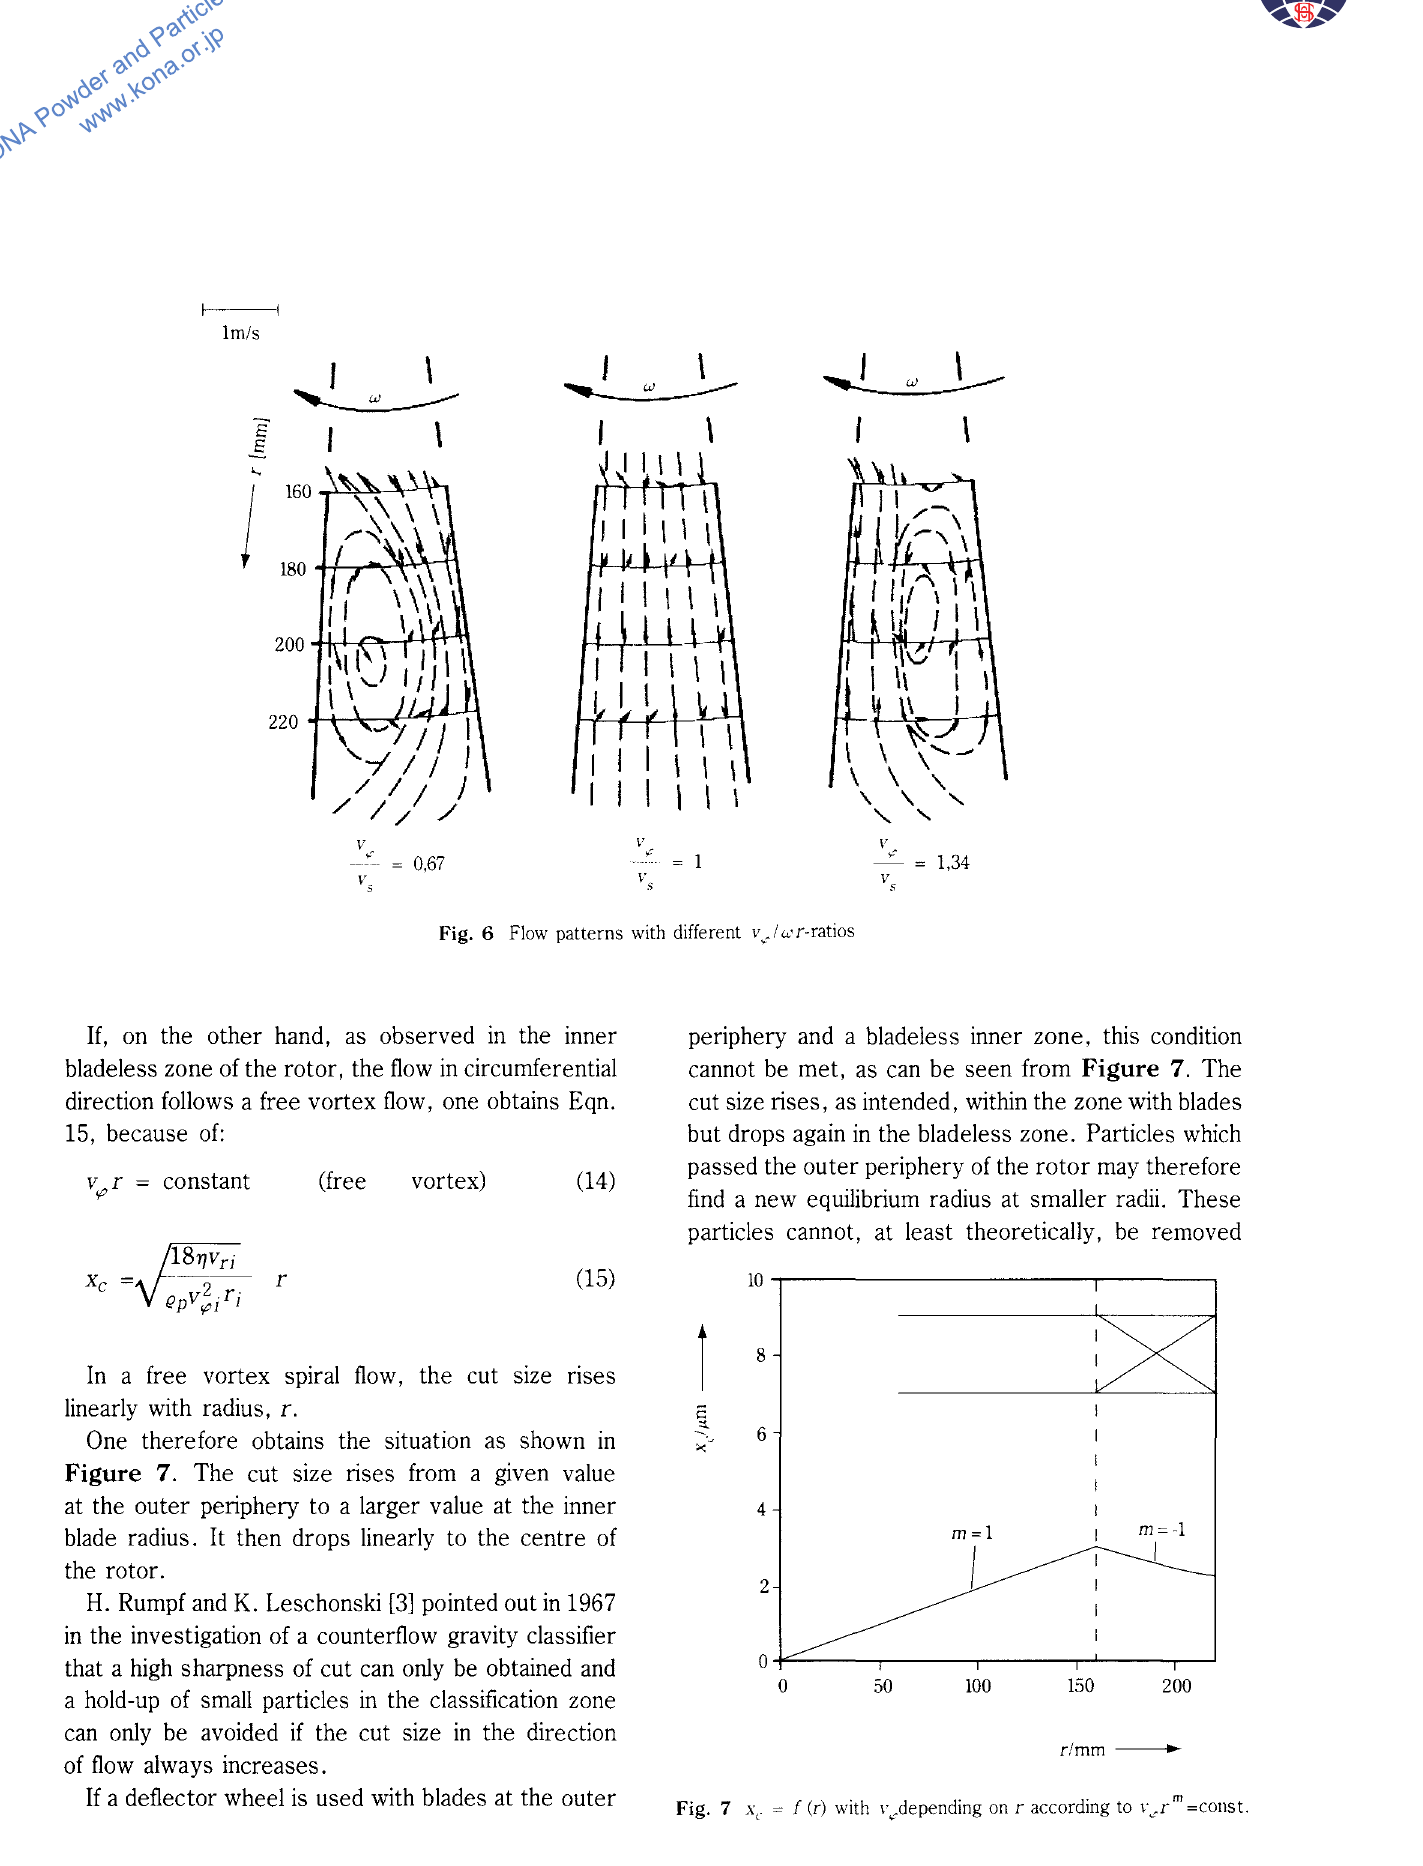
Fig. 7 xc = f (r) with 1·_.depending on r according to 1·,rm =const.